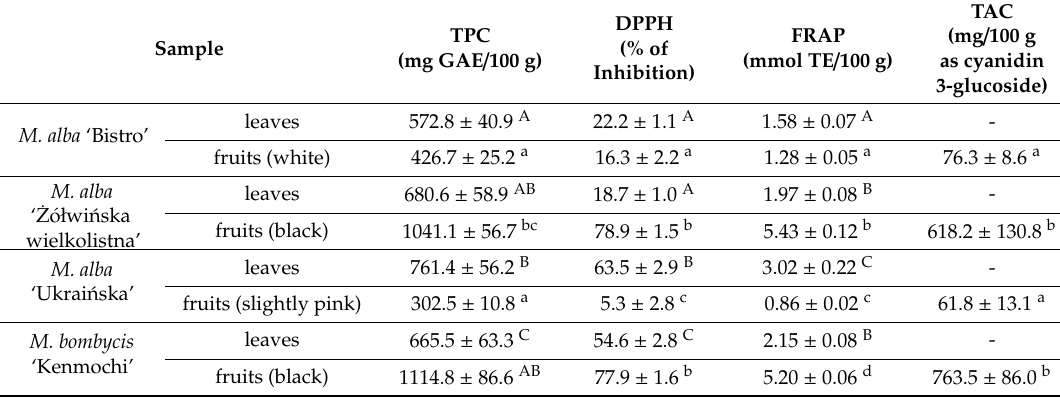
Table 1. Total phenolics content (TPC), radical scavenging activity (2,2-diphenyl-1-picrylhydrazyl (DPPH) test), reducing antioxidant powers (ferric reducing ability of plasma (FRAP) assay) for leaves and fruits, and total anthocyanins content (TAC) for fruits of tested mulberry cultivars expressed per dry